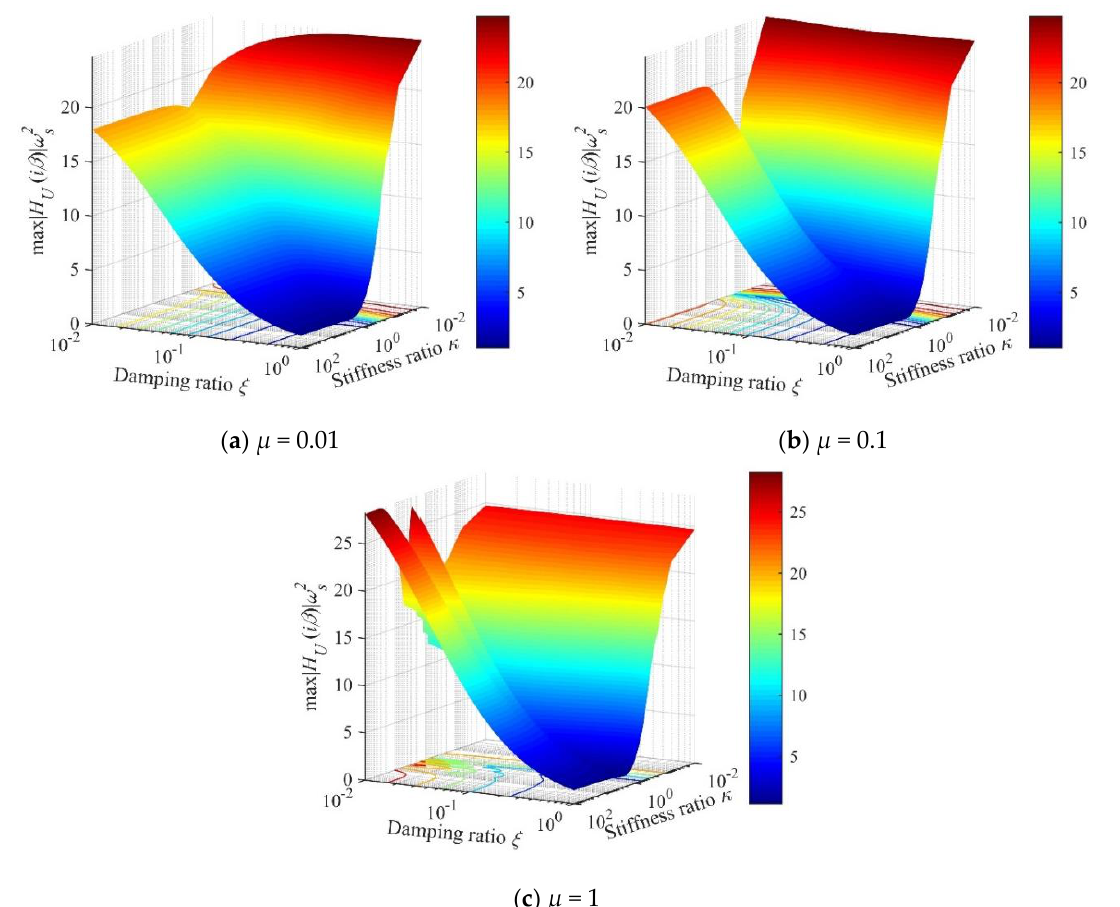
Figure 5. Displacement amplification factor of a CBIS-equipped SDOF structure with changes in κ ∈ [ 0.01,100 ] and ξ ∈ [ 0.01,1 ]